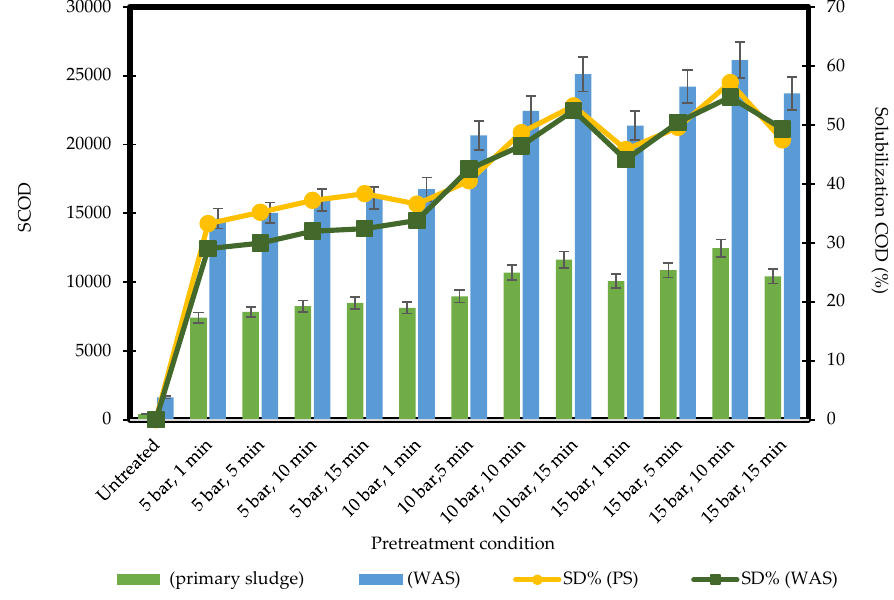
Figure 3. Increase of solubilized COD by steam explosion pretreatment.